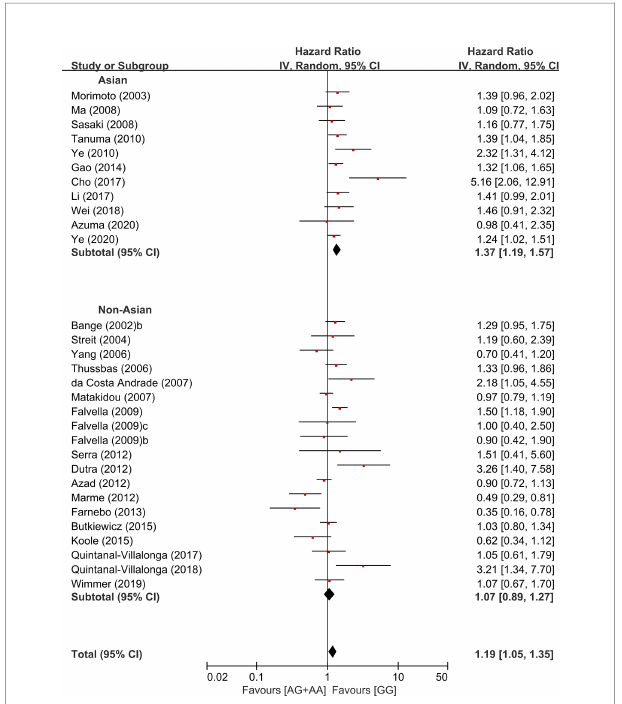
FIGURE 5 | Subgroup analyses according to the